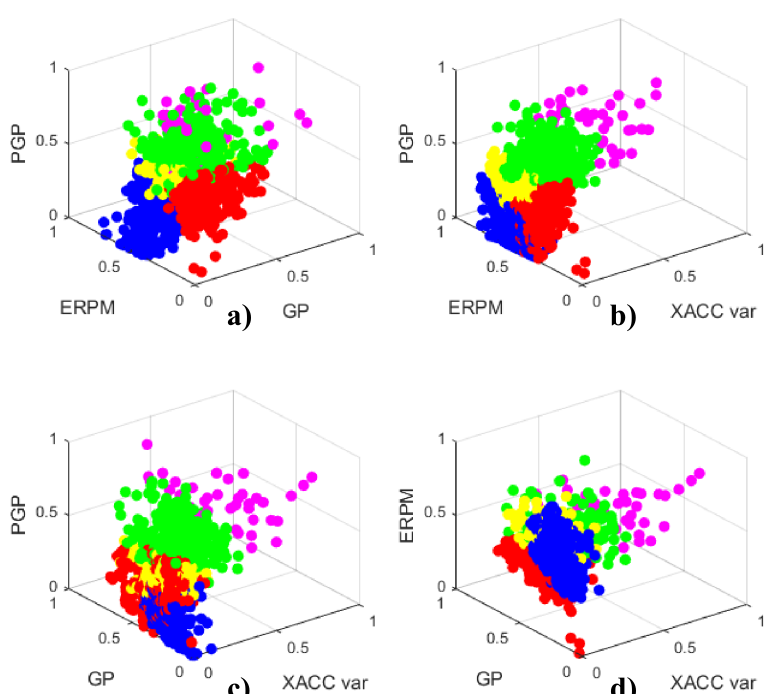
Figure 10. Three-dimensional views of the five-cluster fuel consumption classification results. The clusters were labeled as Very low (red), Low (blue), Medium (yellow), High (green), and Very high (magenta). ( a ) Displays the cluster distribution considering PGP, ERPM and GP. ( b ) Considers PGP, ERPM and XACC var. ( c ) Displays clusters regarding PGP, GP and XACC var, and ( d ) considers ERPM, GP and XACC var.